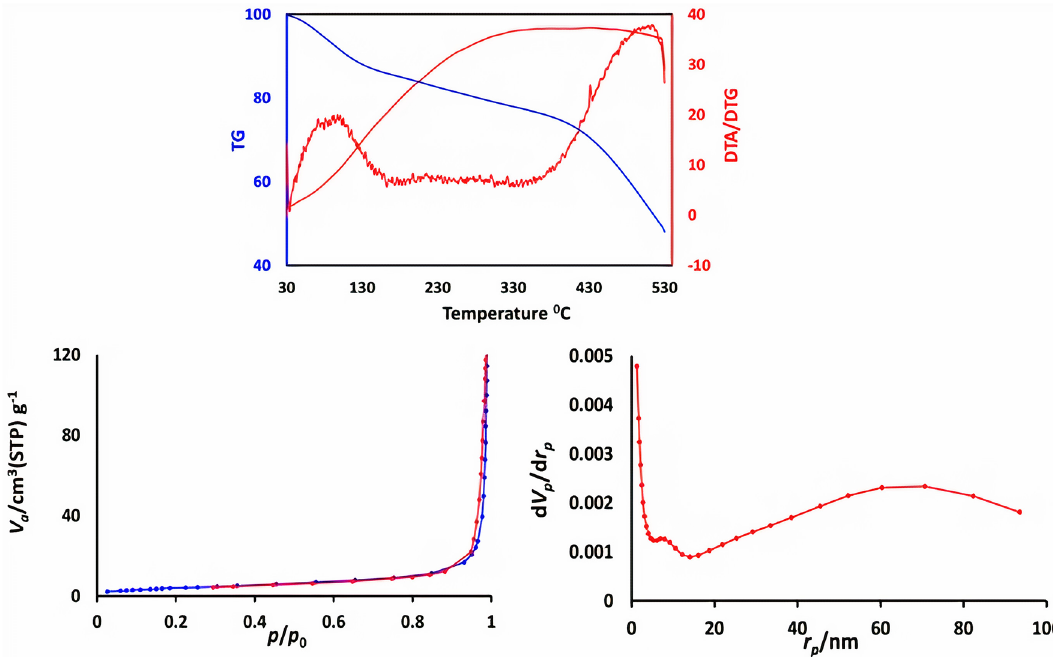
Figure 6. Up: TG, DTG and DTA analysis of [Zr-UiO-66-PDC-SO 3 H]Cl. This figure was prepared by Microsoft Excel (OFFICE 2013). Down: N 2 adsorption/desorption isotherm and pore size distribution (BJH) of